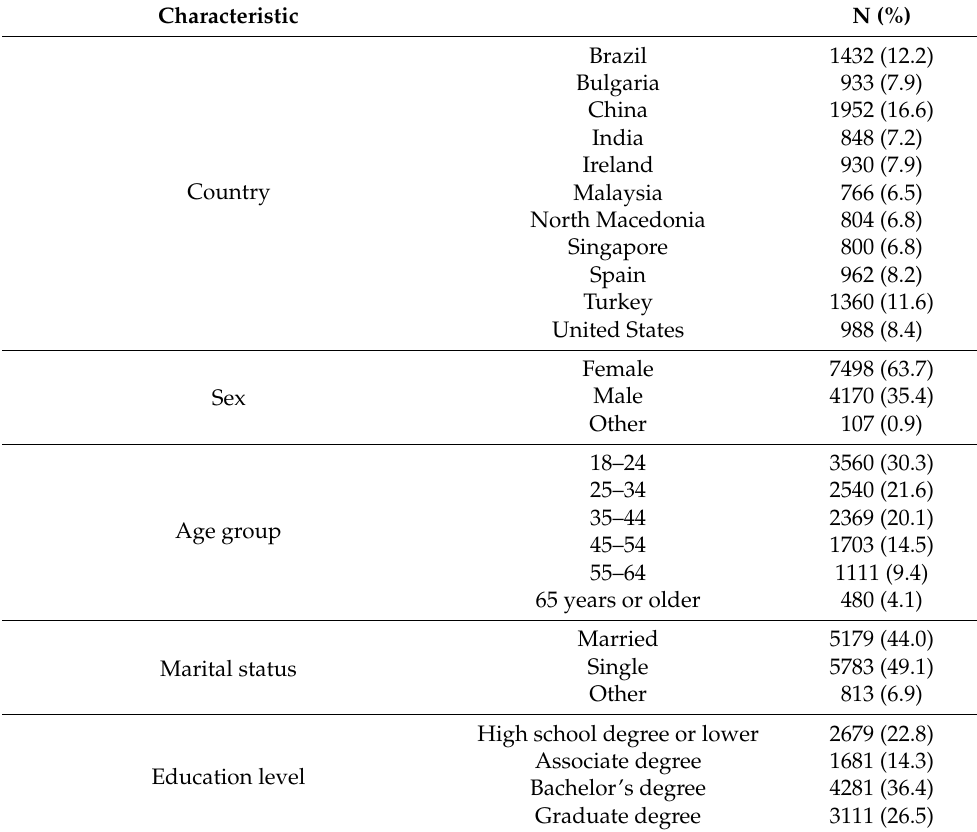
Table 1. Demographic characteristics and mental health symptoms of participants from the 11 partic- ipating countries (n =